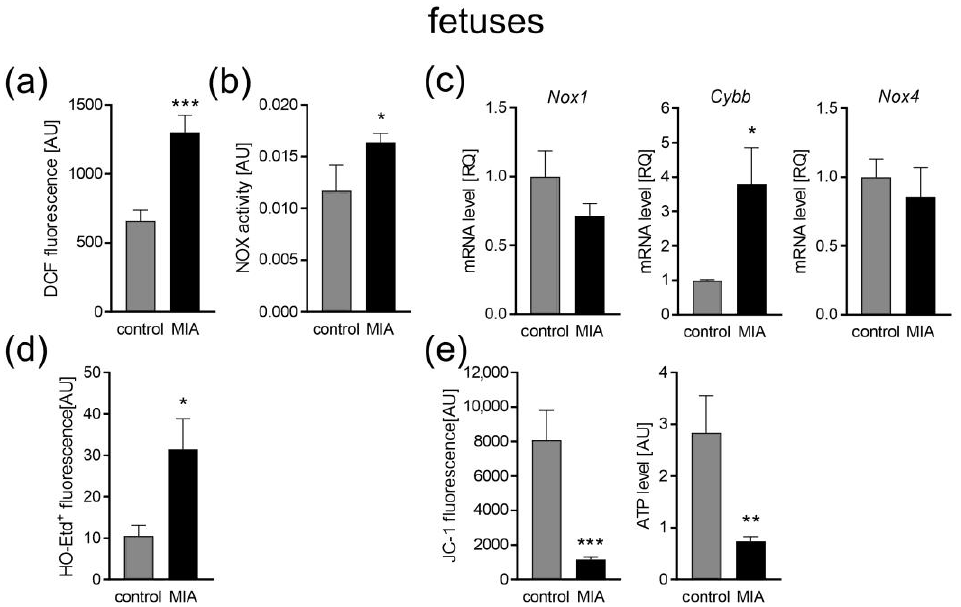
Figure 2. The effect of MIA on oxidative stress and mitochondrial function in fetuses. Twenty-four hours after maternal LPS administration, rat fetuses were sacrificed and whole brains were col- lected. ( a ) The level of ROS was determined with a DCFH-DA probe (n = 8). ( b ) The activity of NADPH oxidase (NOX) was determined by the initial rate of inhibitable ferricytochrome c reduc- tion (n = 5 and 7). ( c ) The mRNA levels of NOX subunits Nox1 , Cybb, and Nox4 were determined using real-time PCR and were calculated by the ΔΔCt method with Actb (β-actin) as a reference gene (n = 6 and 5). ( d ) The generation of superoxide radicals was determined by the fluorimetric method using DHE (n = 4). ( e ) The mitochondrial membrane potential was determined by the fluorometric method using JC-1 and the mitochondrial ATP level was determined using the bioluminescence as-